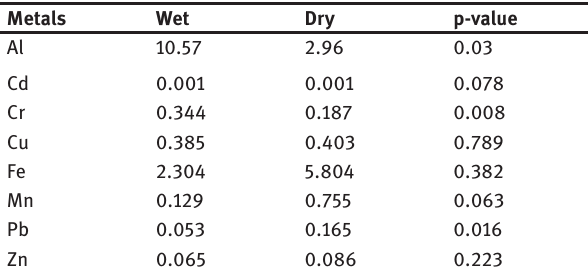
Table 2a: Mean concentrations of trace metal levels (mg/L) in the wet and the dry season of the water of Nzhelele River and the difference in their means at p = 0.05.